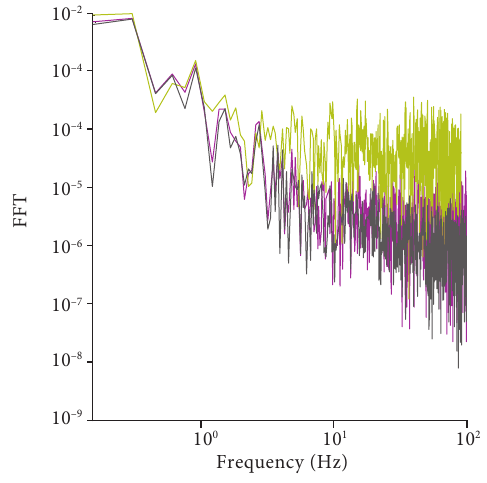
Figure 15. Sensors energy level at angle of attack of 3°.